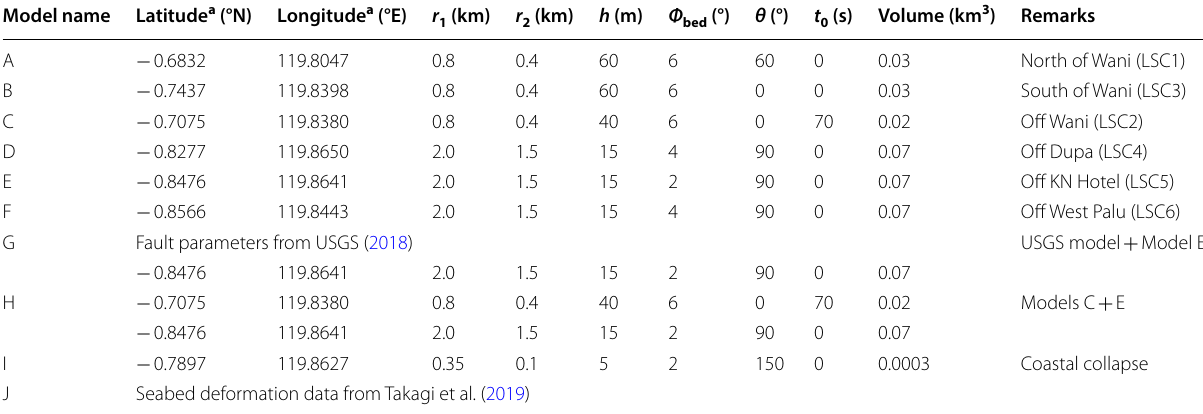
Table 1 Parameters of submarine landslide mass sources